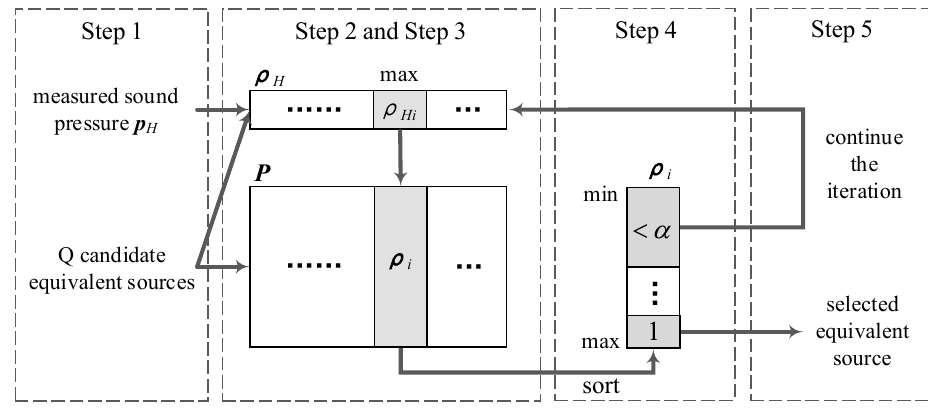
Figure 2. The flow chart of the optimization